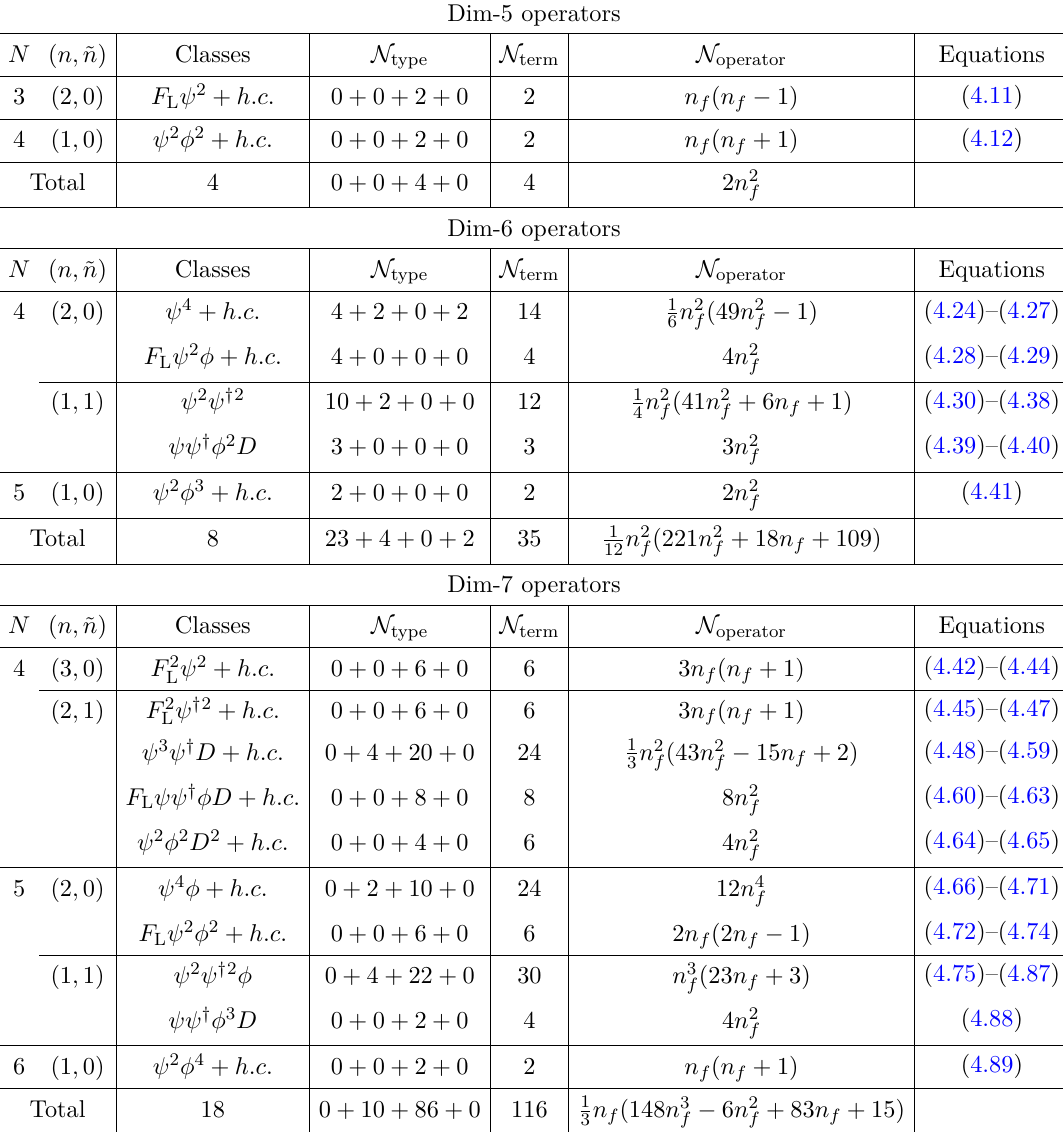
Table 3 . The complete statistics of dimension 5, 6, 7 ν SMEFT operators. N in the leftmost column shows the number of particles. ( n, ˜ n ) are the numbers of (cid:15) and ˜ (cid:15) in the Lorentz structure. N type , N term , and N operator show the number of types, terms and Hermitian operators respectively (independent conjugates are counted), while the numbers under N describe the sum of each type possible | ∆ L | types/operators with N = N ( | ∆ L | = 0)+ N ( | ∆ L | = 1)+ N ( | ∆ L | = 2)+ N ( | ∆ L | = 4) . The links in the rightmost column refer to the list(s) of the terms in given